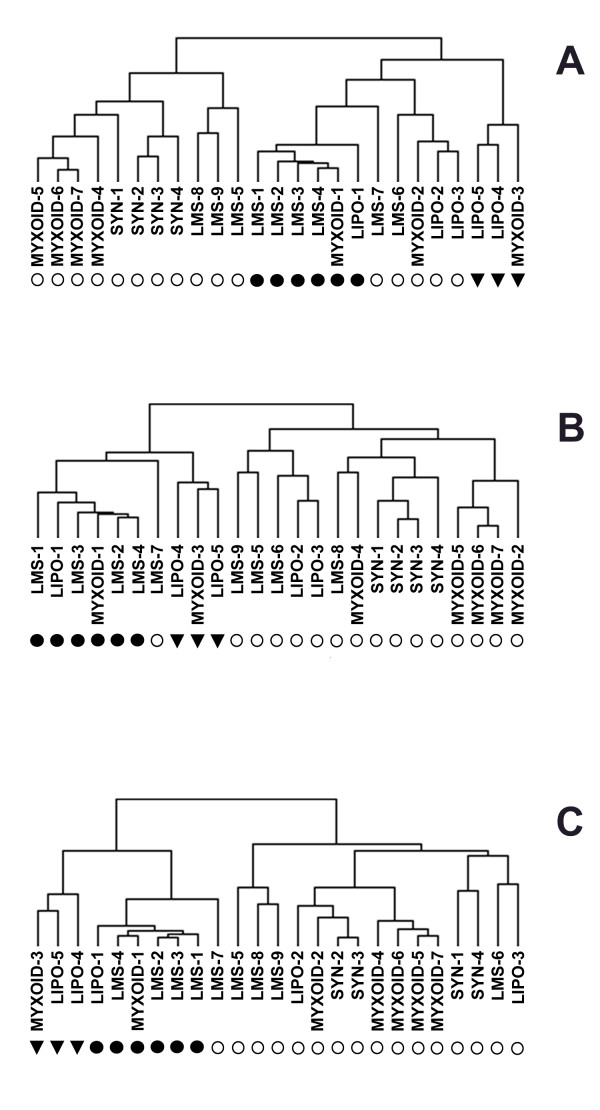
Clustering of gene expression of the STS samples with the RCC gene set (A), OVCA gene set (B), and AF gene set (C). The 25 STS samples were clustered using the Eisen clustering software Cluster as described in the text and are labeled as in Figure 2. The tissue samples in the tree are joined by very short branches if they have gene expression patterns that are very similar to each other, and by increasingly longer branches as their similarity decreases.